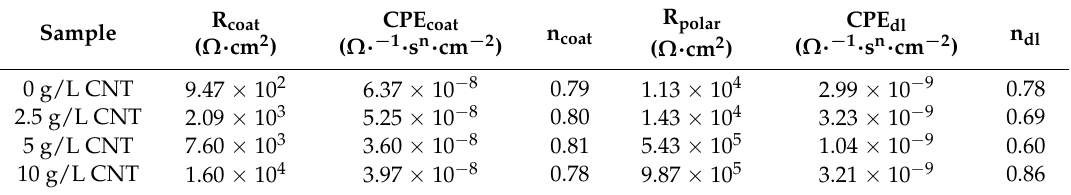
Table 3. Equivalent circuit parameters from fitted Electrochemical Impedance Spectroscopy (EIS) results of PEO coatings formed in the electrolytes containing different amounts of CNT.